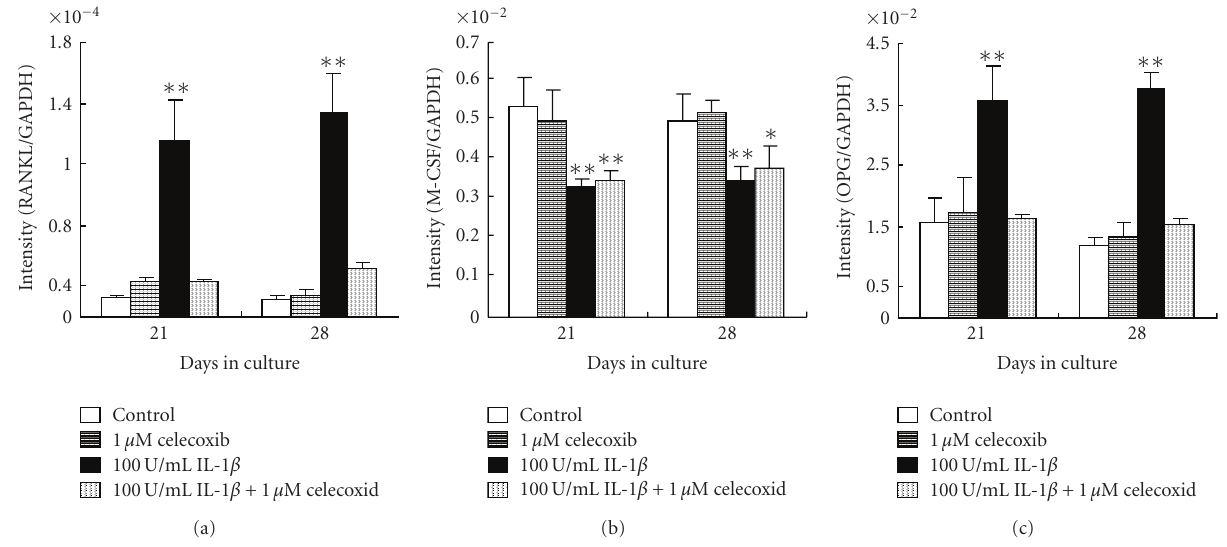
Figure 4: E ff ect of IL-1 β and/or celecoxib on RANKL, M-CSF, and OPG gene expression. Cells were cultured with 0 or 100 U/mL IL-1 β , with or without 1 μ M celecoxib, and RANKL, M-CSF, and OPG gene expression was determined by real-time PCR on days 21 and 28 of culture. Each bar indicates the mean ± SD from four separate experiments. ∗ P < . 05, ∗∗ P < . 01 for IL-1 β treatment versus the